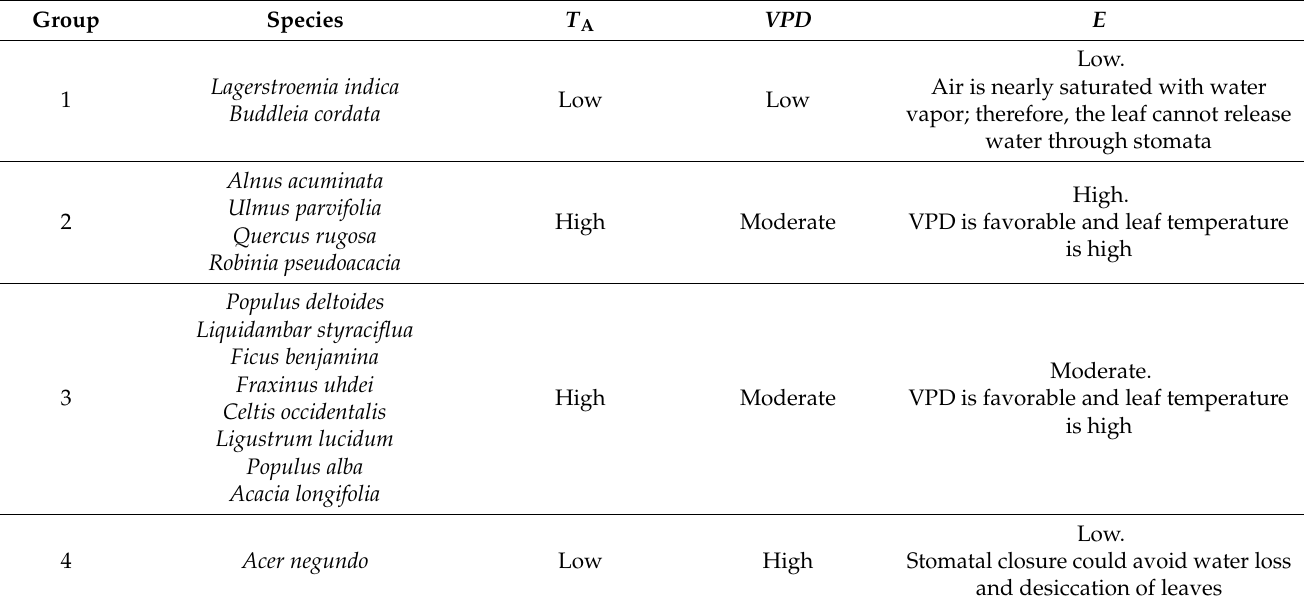
Table 3. Relationships among air temperature ( T A ), vapor pressure deficit ( VPD ) and transpiration ( E ) for 15 dominant urban tree species from eight urban green areas of Mexico City.